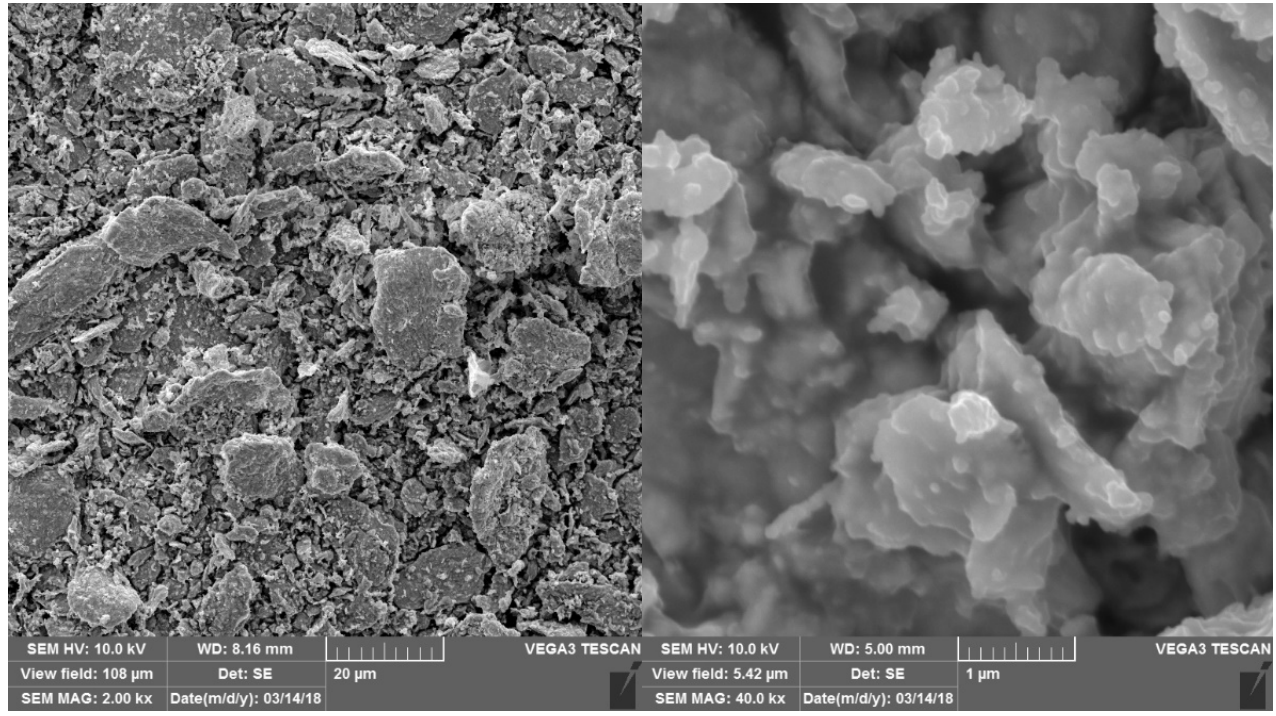
Figure 2. SEM images of Gd powder.